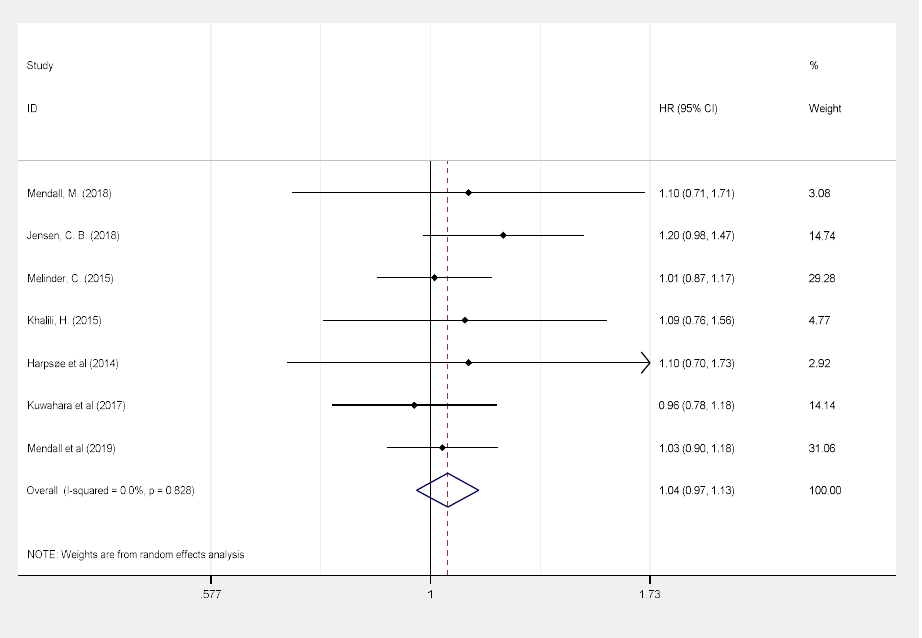
Figure 5. Association between underweight (BMI <18.5 kg/m 2 ) and risk of ulcerative colitis.